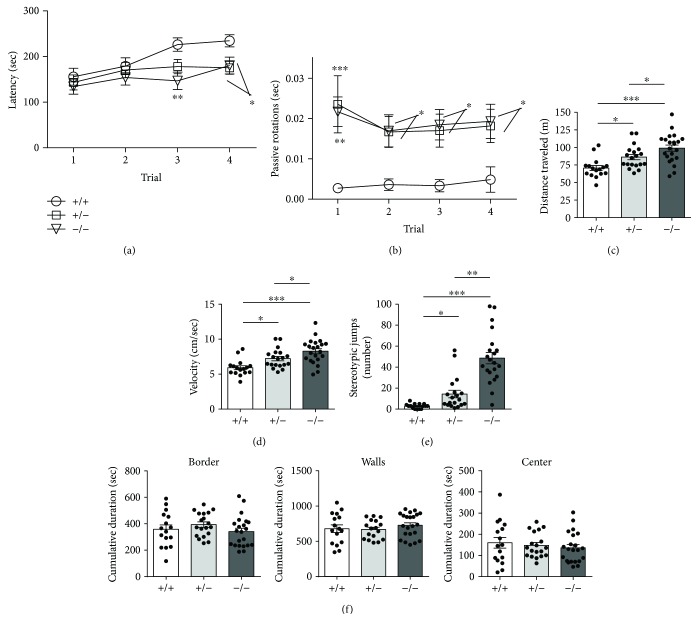
Impaired motor coordination, hyperactivity, and stereotypes in Cdkl5 +/− female mice. (a, b) Rotarod assay, measuring latency to fall (a) and frequency of passive rotations (b; rotations in which the mouse does not perform any coordinated movement but is passively transported from the rotating apparatus) on the accelerating rotating rod. Testing was performed in 4 trials with an intertrial interval of 1 h. Cdkl5 +/− (n = 21) and Cdkl5 −/− (n = 23) mice showed a decreased latency to fall (a) and an increased frequency of passive rotations compared to Cdkl5 +/+ (n = 17) mice, indicating impaired motor coordination in Cdkl5 +/− and Cdkl5 −/− mice. (c, d) Locomotor activity measured as total distance traveled (c) and average locomotion velocity (d) during a 20 min open-field test. Cdkl5 +/− (n = 19) and Cdkl5 −/− (n = 22) mice exhibited increased locomotor activity with a longer total distance traveled (c) at a greater average speed (d) compared to Cdkl5 +/+ (n = 16) mice. (e) Number of stereotypic jumps (repetitive beam breaks < 1 s) in the corners of the open-field arena during the 20 min trial. Cdkl5 +/− (n = 19) and Cdkl5 −/− (n = 21) mice showed an increased number of repetitive stereotyped jumps compared to Cdkl5 +/+ (n = 15) mice. (f) Time (cumulative duration) spent by the border, near the walls, and in the center of the open-field arena. Cdkl5 +/+, Cdkl5 +/−, and Cdkl5 −/− mice spent a comparable time at the border, near the walls, and in the center compared to controls, suggesting that hyperactivity was not due to increased anxiety. Values represent mean ± SEM. ∗
p < 0.05, ∗∗
p < 0.01, and ∗∗∗
p < 0.001 (datasets in (a–d, f), Fisher's LSD test after ANOVA; datasets in (e) Dunn's test after Kruskall-Wallis).